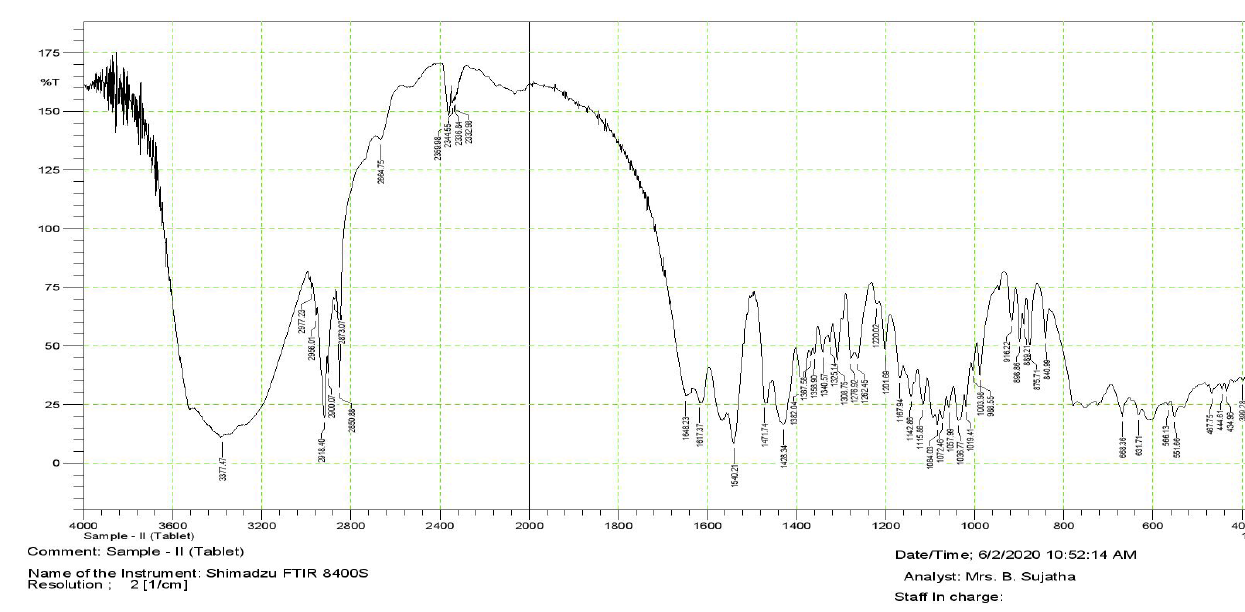
TABLE II - Weight of calcium oxalate tablet before and after treatment